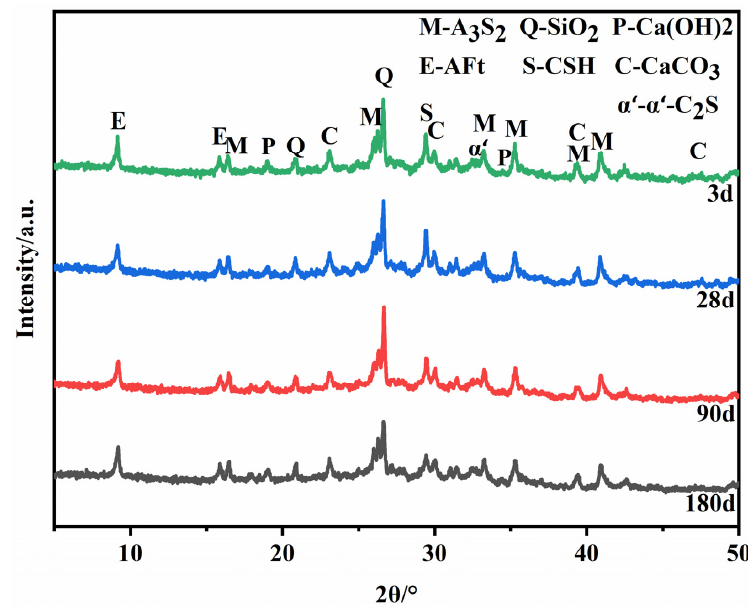
Figure 8. XRD patterns of hydration products of the samples.